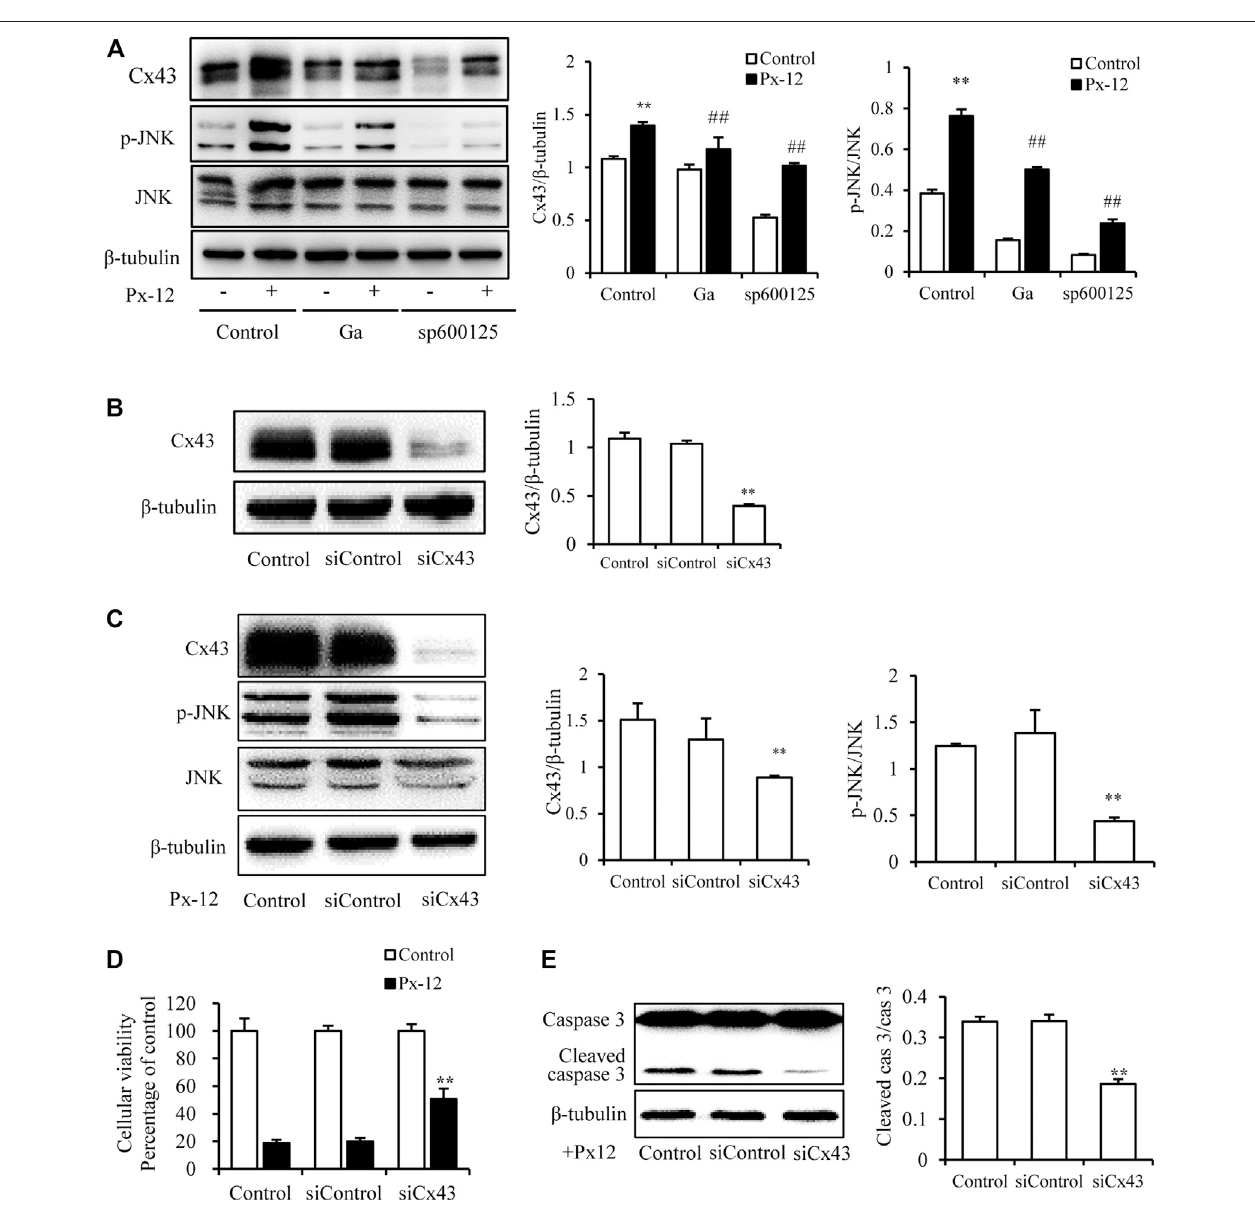
FIGURE 4 | Reciprocal modulation of connexin 43 (Cx43) and c-Jun N-terminal kinase (JNK). (A) Effect of 18 α -glycyrrhetinic acid (Ga) and sp600125 on JNK phosphorylationandexpressionofCx43.NRK-52E cellsinsix-wellplateswerepretreatedwithGaandsp600125for1 handthenchallengedwithPx-12foranother1 h. Cellular lysates werethen analyzed bywesternblottingforphosphorylatedJNKand Cx43expression.Densitometric analysisof p -JNK and Cx43 areshownon theright (mean ± SD, n (cid:2) 3; ** p < 0.01 vs. the control, ## p < 0.01 vs. Px-12 in the control). (B) NRK-52E cells were transfected with either Cx43 siRNA or siRNA control for 24 h. Cellular lysates were analyzed by western blotting for Cx43 expression. Densitometric analysis of Cx43 is shown on the right (mean ± SD, n (cid:2) 3; ** p < 0.01 vs. the siRNA control group). (C) Effect of Cx43 siRNA on JNK phosphorylation and Cx43 expression. The transfected or normal cells were incubated with Px-12 for 1 h separately.Then,cellularlysateswereanalyzedbywesternblottingforphosphorylatedJNKandCx43expression.Densitometricanalysisof p -JNKandCx43areshown on the right (mean ± SD, n (cid:2) 3; ** p < 0.01 vs. the control, ## p < 0.01 vs. Px-12 in the siRNA control group). (D) Effect of Cx43 siRNA on cell viability. The transfected or normal cells were incubated with Px-12 for 24 h. Then, cell viability was evaluated using a Cell Counting Kit-8 (CCK-8) assay. Data are expressed as the percentage of living cells vs. the untreated control (mean ± SD, n (cid:2) 6). * p < 0.01 vs. Px-12 in normal cells. ## p < 0.01 vs. Px12 in the siRNA control group. (E) Effect of Cx43 siRNA on caspase-3 activation. The transfected or normal cells were incubated with Px-12 for 24 h. Then, cellular lysates were analyzed by western blotting for expression of cleaved caspase-3. Densitometric analysis of cleaved caspase-3 and caspase-3 are shown on the right (mean ± SD, n (cid:2) 3; ** p < 0.01 vs. Px-12 in the siRNA control